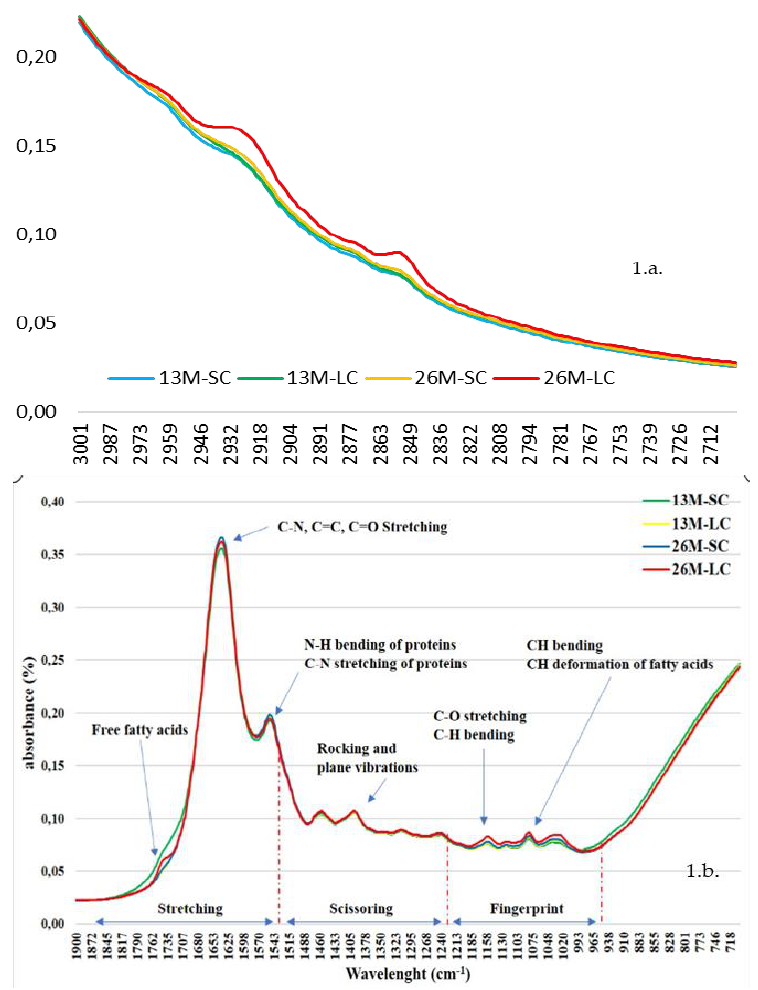
Figure 1. Spectral characteristics of the samples from 13- and 26-month-old foals (13M, 26M) and supplemented with standard and linseed concentrate (SC, SL). Range selected from 3000–2700 cm −